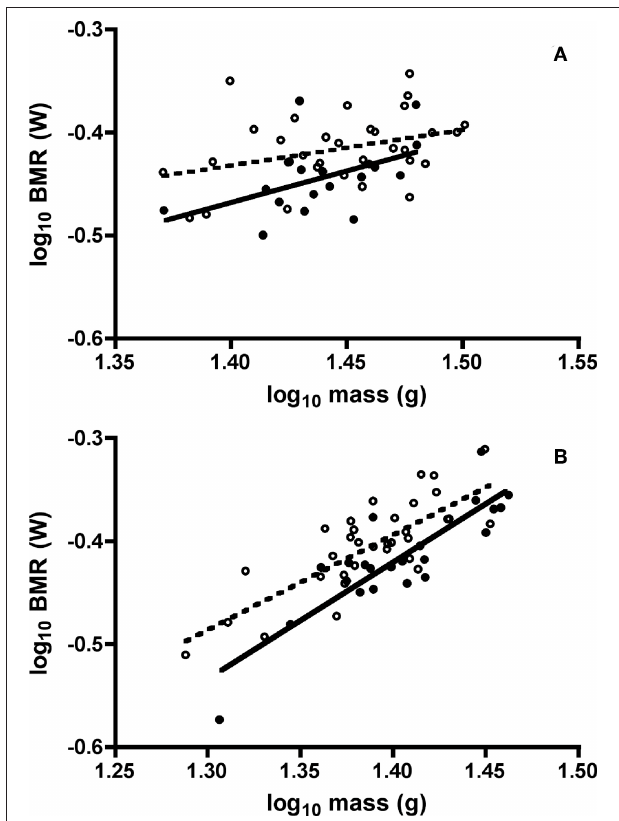
FIGURE 4 | Effect of mass on basal metabolic rates (BMR) of juvenile and adult (A) Swainson’s thrushes and (B) white-throated sparrows captured at Long Point, ON, Canada, during fall 2010 migratory stopover. Unfilled circles and dashed line represent juveniles: thrushes log 10 BMR = − 0.919 ( ± 0.244) + 0.348 ( ± 0.168) * log 10 mass, r 2 = 0.121; sparrows log 10 BMR = − 1.686 ( ± 0.179) + 0.923 ( ± 0.129) * log 10 mass, r 2 = 0.610. Filled circles and solid line represent adults: thrushes log 10 BMR = − 1.333 ( ± 0.416) + 0.618 ( ± 0.289) * log 10 mass, r 2 = 0.234; sparrows log 10 BMR = − 2.009 ( ± 0.214) +